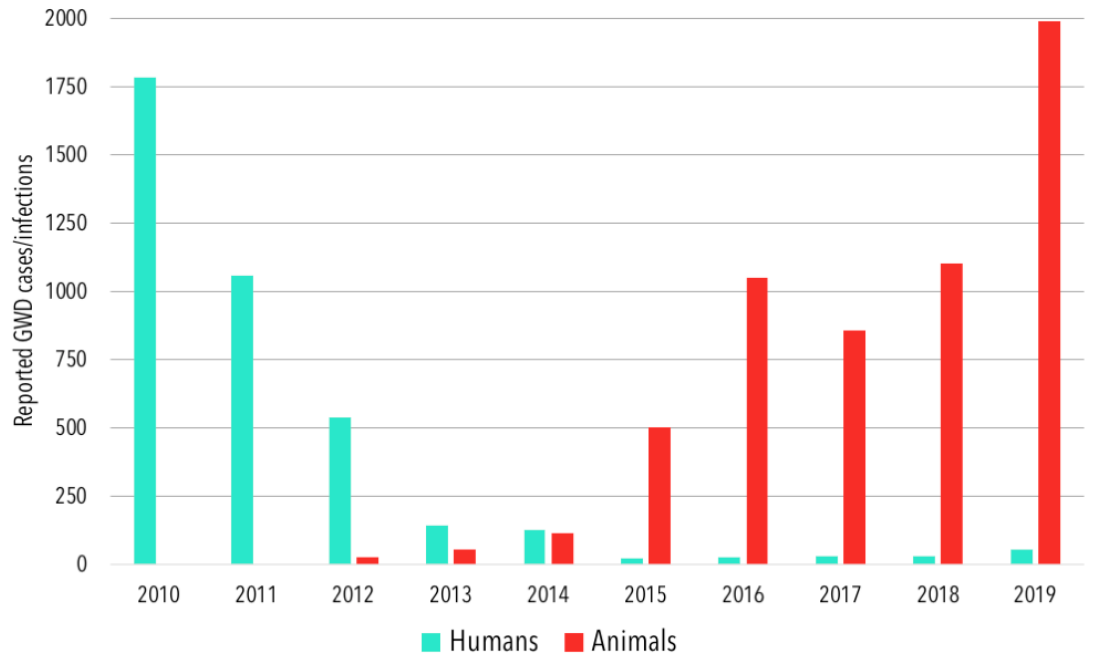
Figure 1. The total annual reported human cases and animal infections of Guinea worm disease in Angola, Cameroon, Chad, Ethiopia, Mali, and South Sudan, 2010–2019.